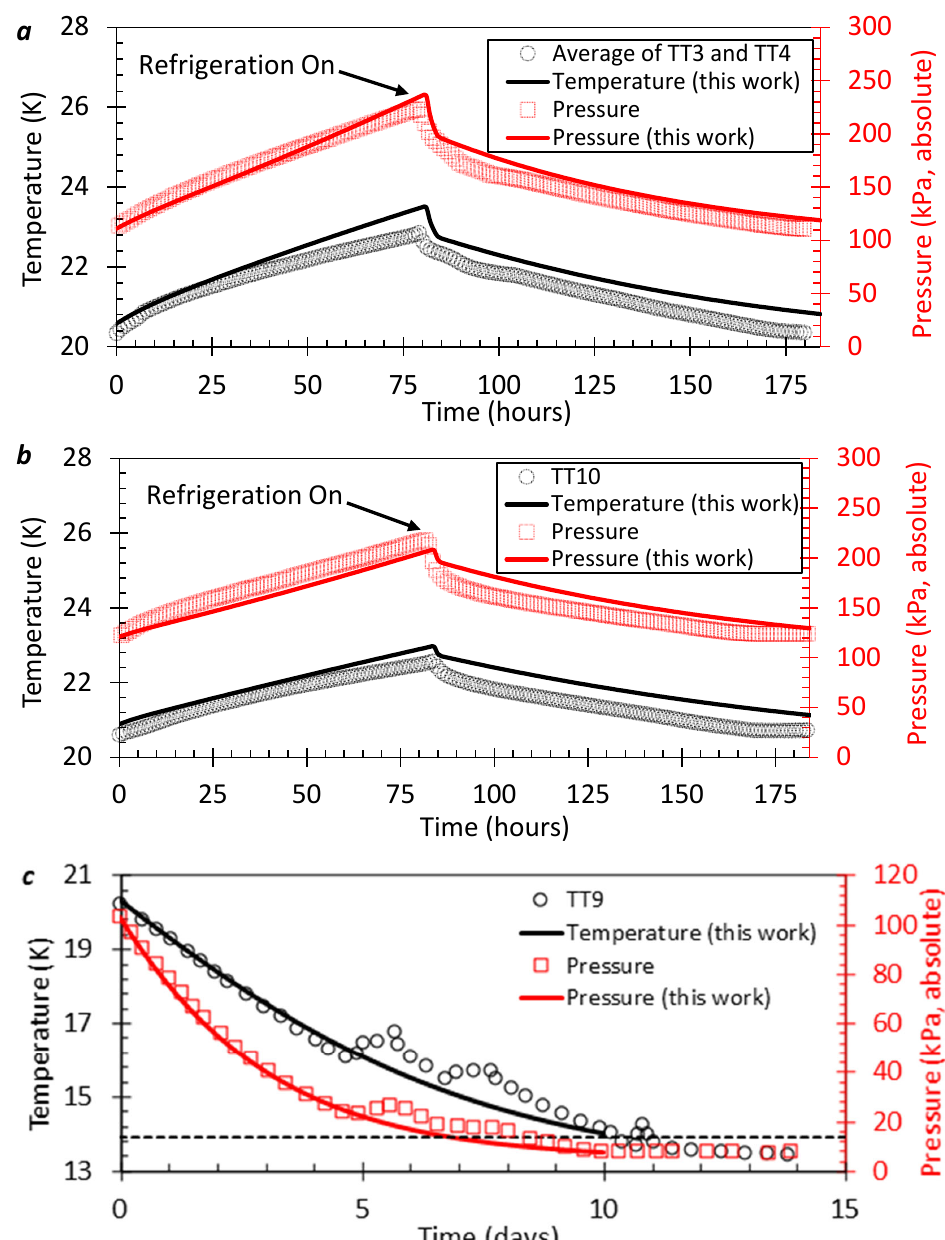
Figure 4. Comparison between the BoilFAST calculations (solid curves) and experimental data (symbols) obtained from a LH 2 horizontal storage tank at NASA’s Kennedy Space Centre. ( a ) 33% duty-cycle experiment, ( b ) 67% duty-cycle experiment, and ( c ) 46% densification experiment to hydrogen’s triple point, which is indicated using a dashed line. TT4, TT10, and TT9 correspond to temperature sensors located at different depths inside the horizontal storage tank.